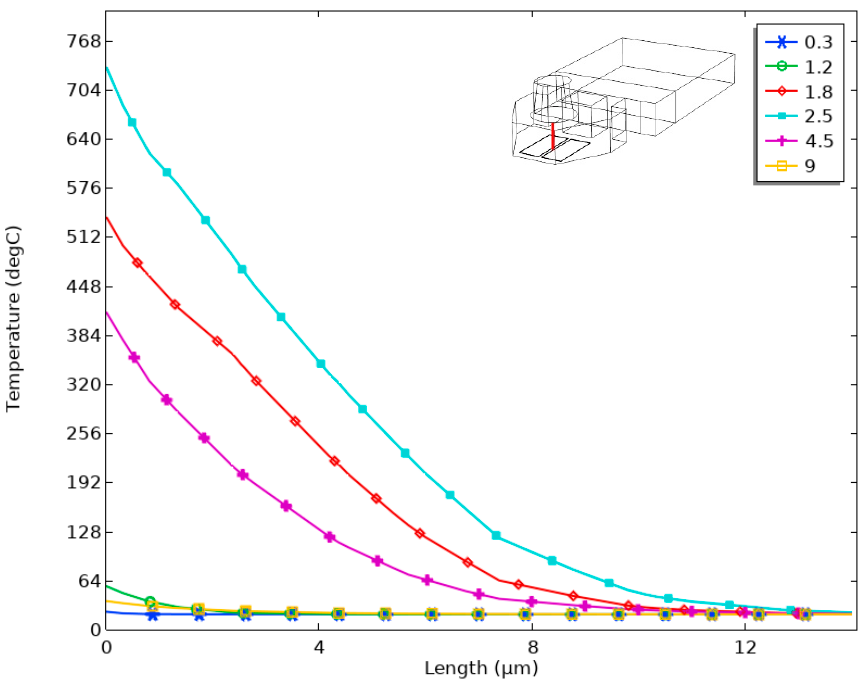
Figure 9. At different times, the temperature changed with the different heights of the straight line.